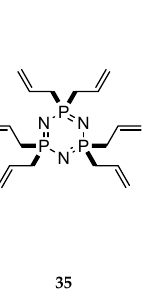
Figure 14. Chemical structures of 35 and 36 .